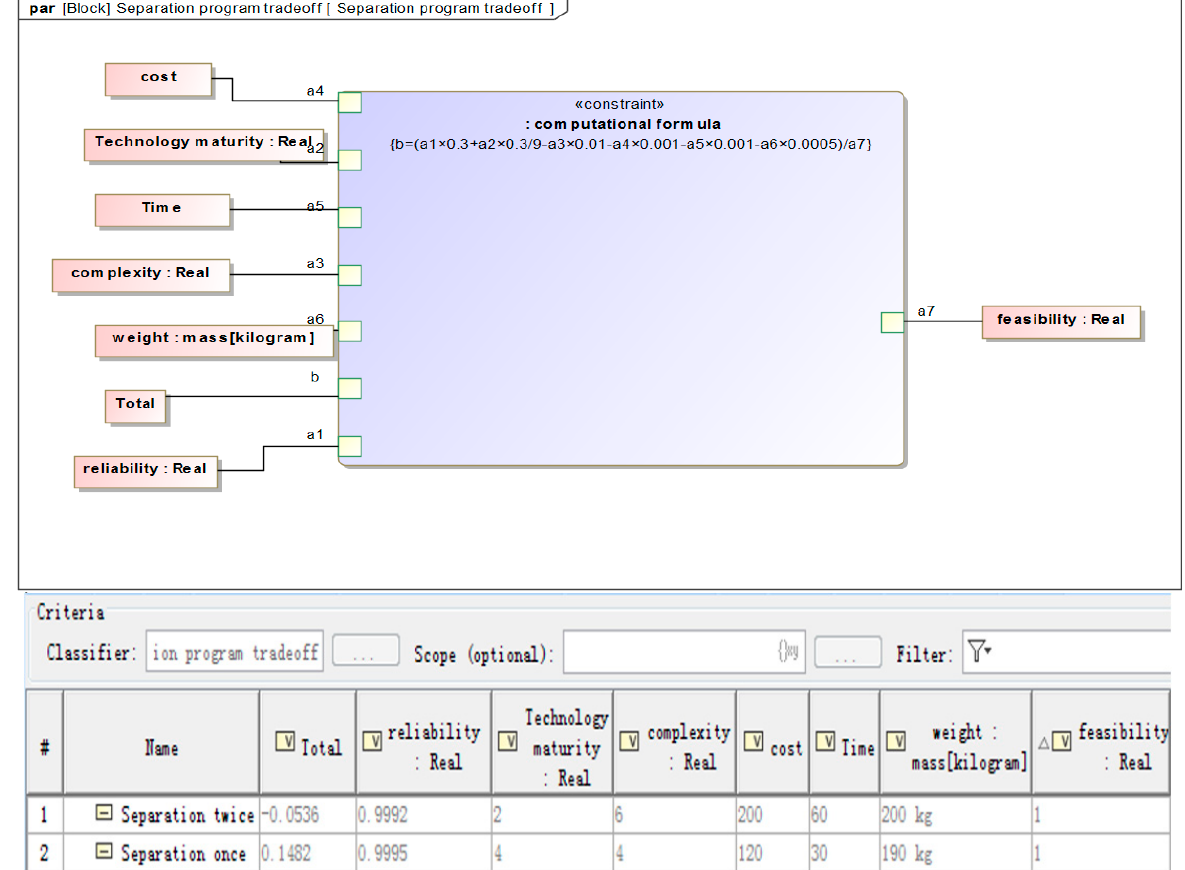
Figure 7. The tradeoffs result in functional architecture.